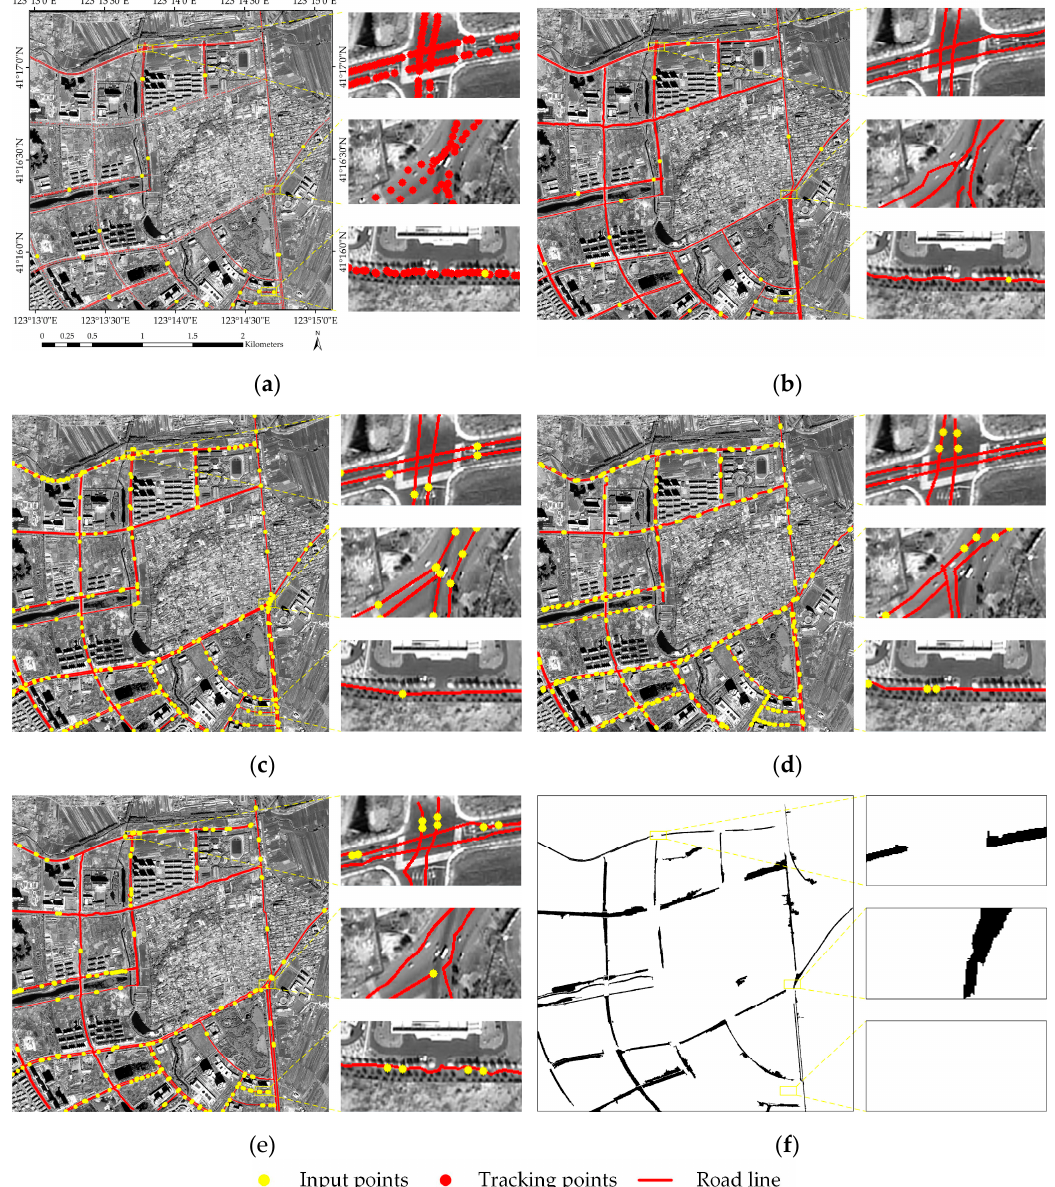
Figure 15. Third study area: ( a ) Tracking point result diagram; ( b ) road extraction result of proposed method; ( c ) road extraction result of the ERDAS method; ( d ) road extraction result of the T-shaped template-matching method; ( e ) road extraction result of the rectangle method; ( f ) road extraction result of the eCognition method.